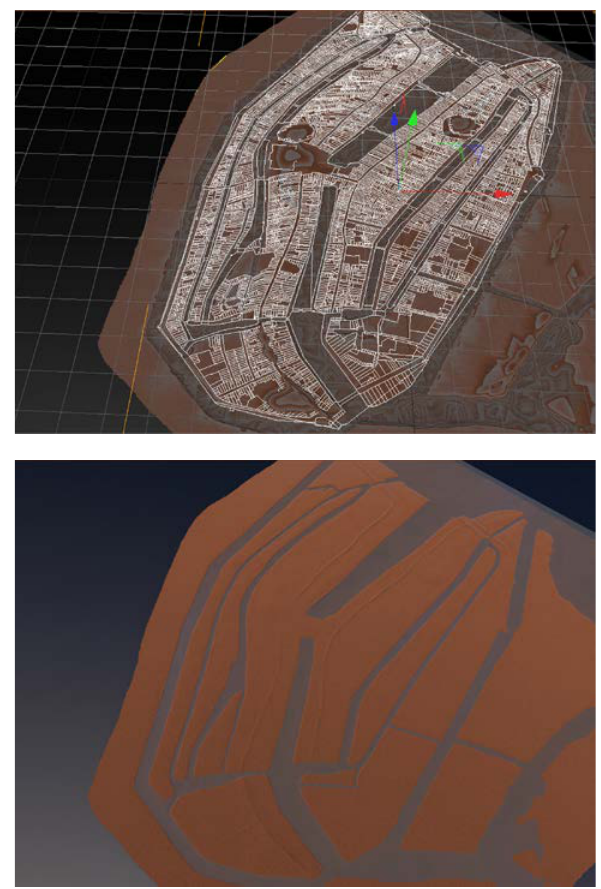
Figure 1. The GIS map imported in Cinema4D and landscape reconstructed (images by L. Opgenhaffen)